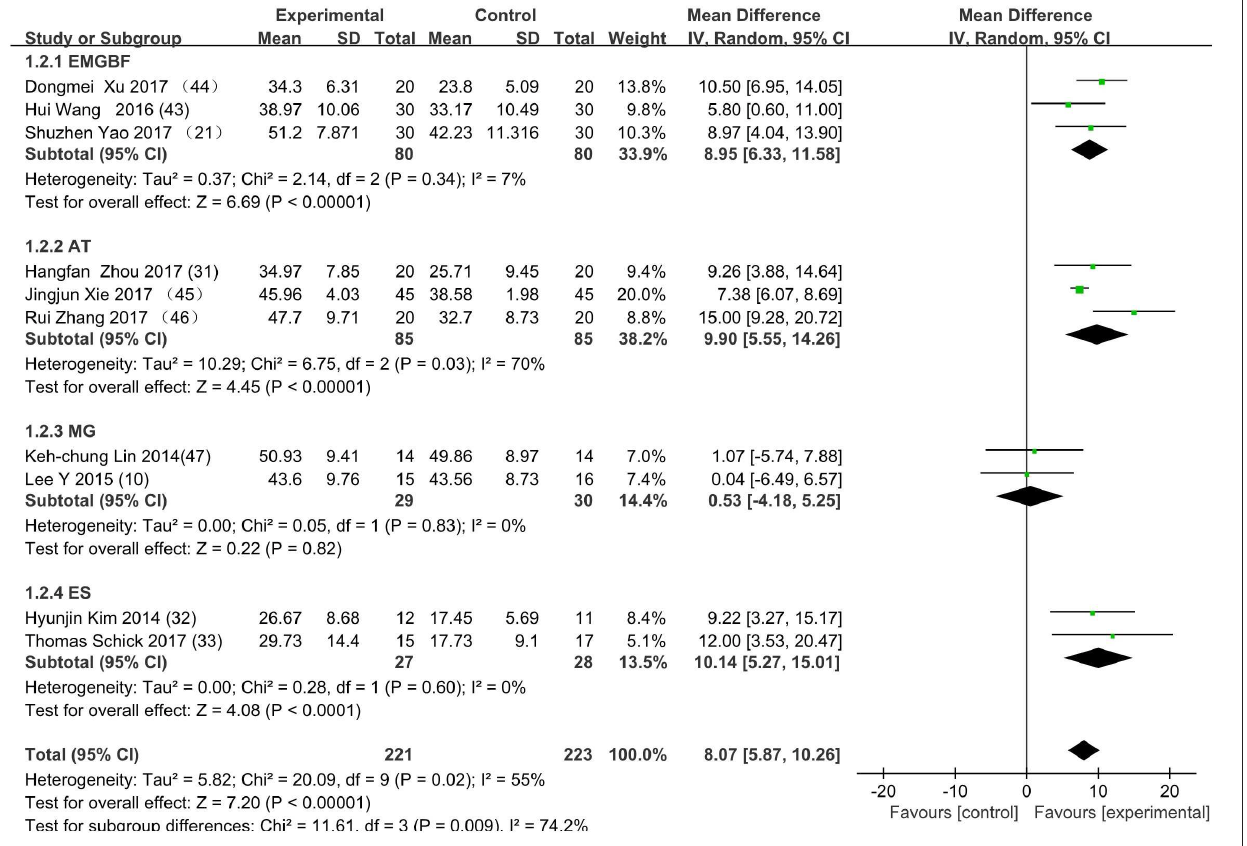
FIGURE 4 | Subgroup analysis for the high heterogeneity. SD: standard deviation; 95% CI: 95% confidence interval. EMGBF: Electromyographic biofeedback; AT: Acupuncture; MG: mesh glove; ES: electrical stimulation.